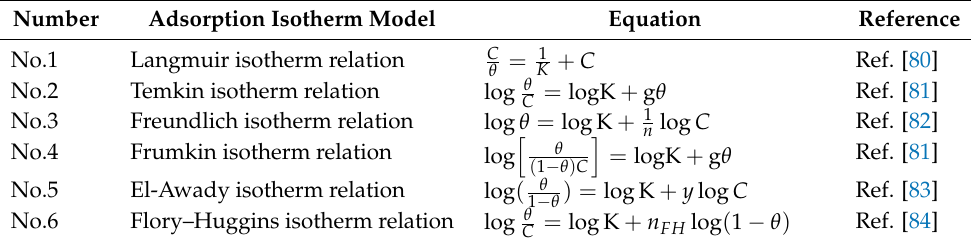
Table 3. The six adsorption isotherm